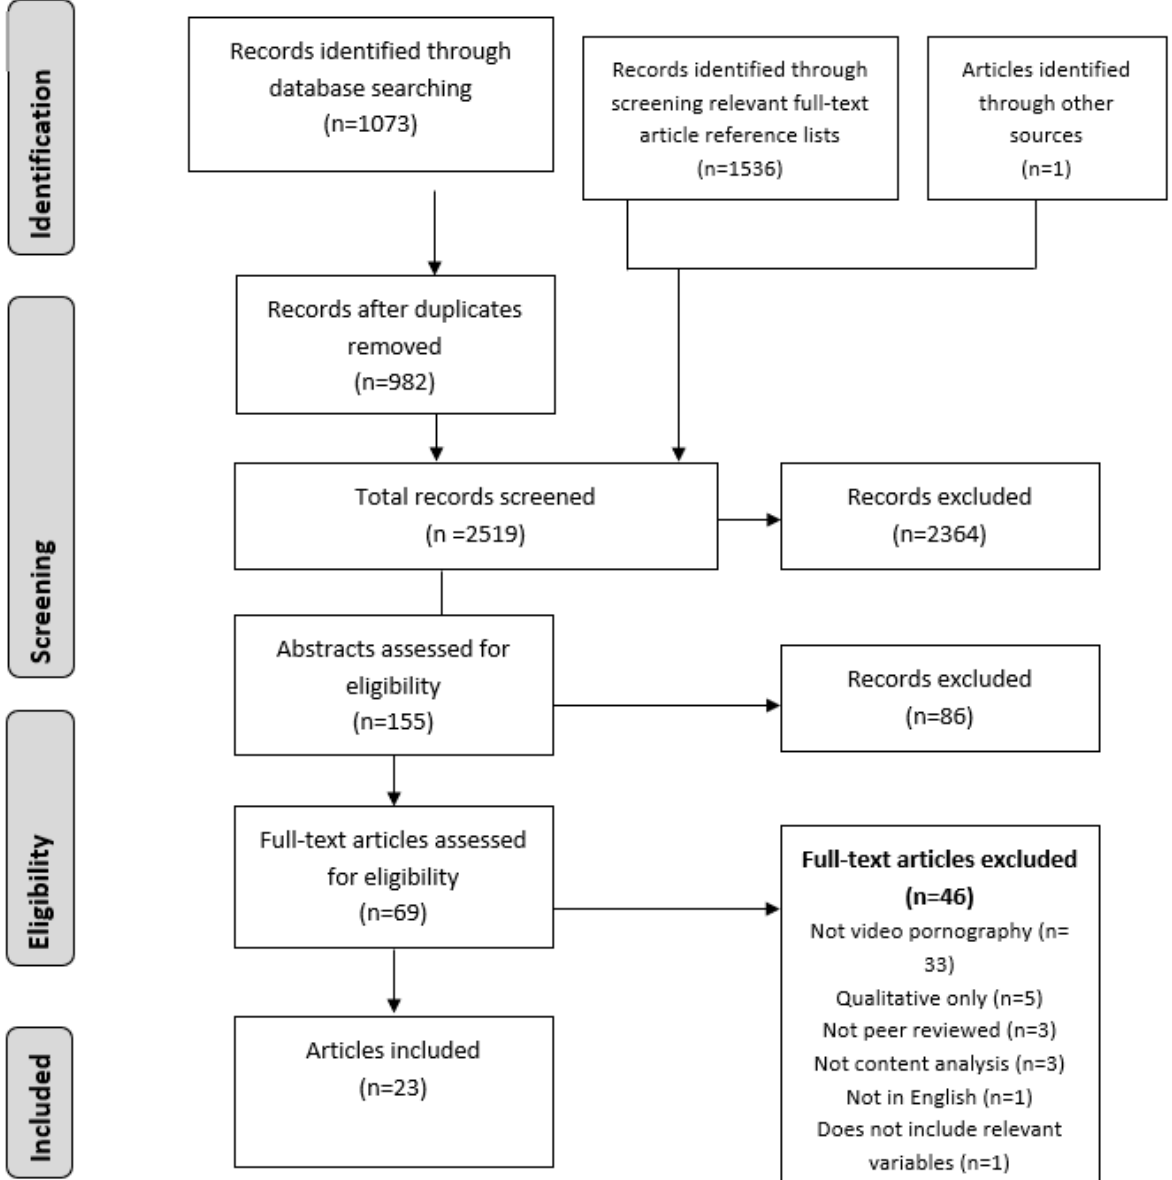
Figure 1. Screening process and article